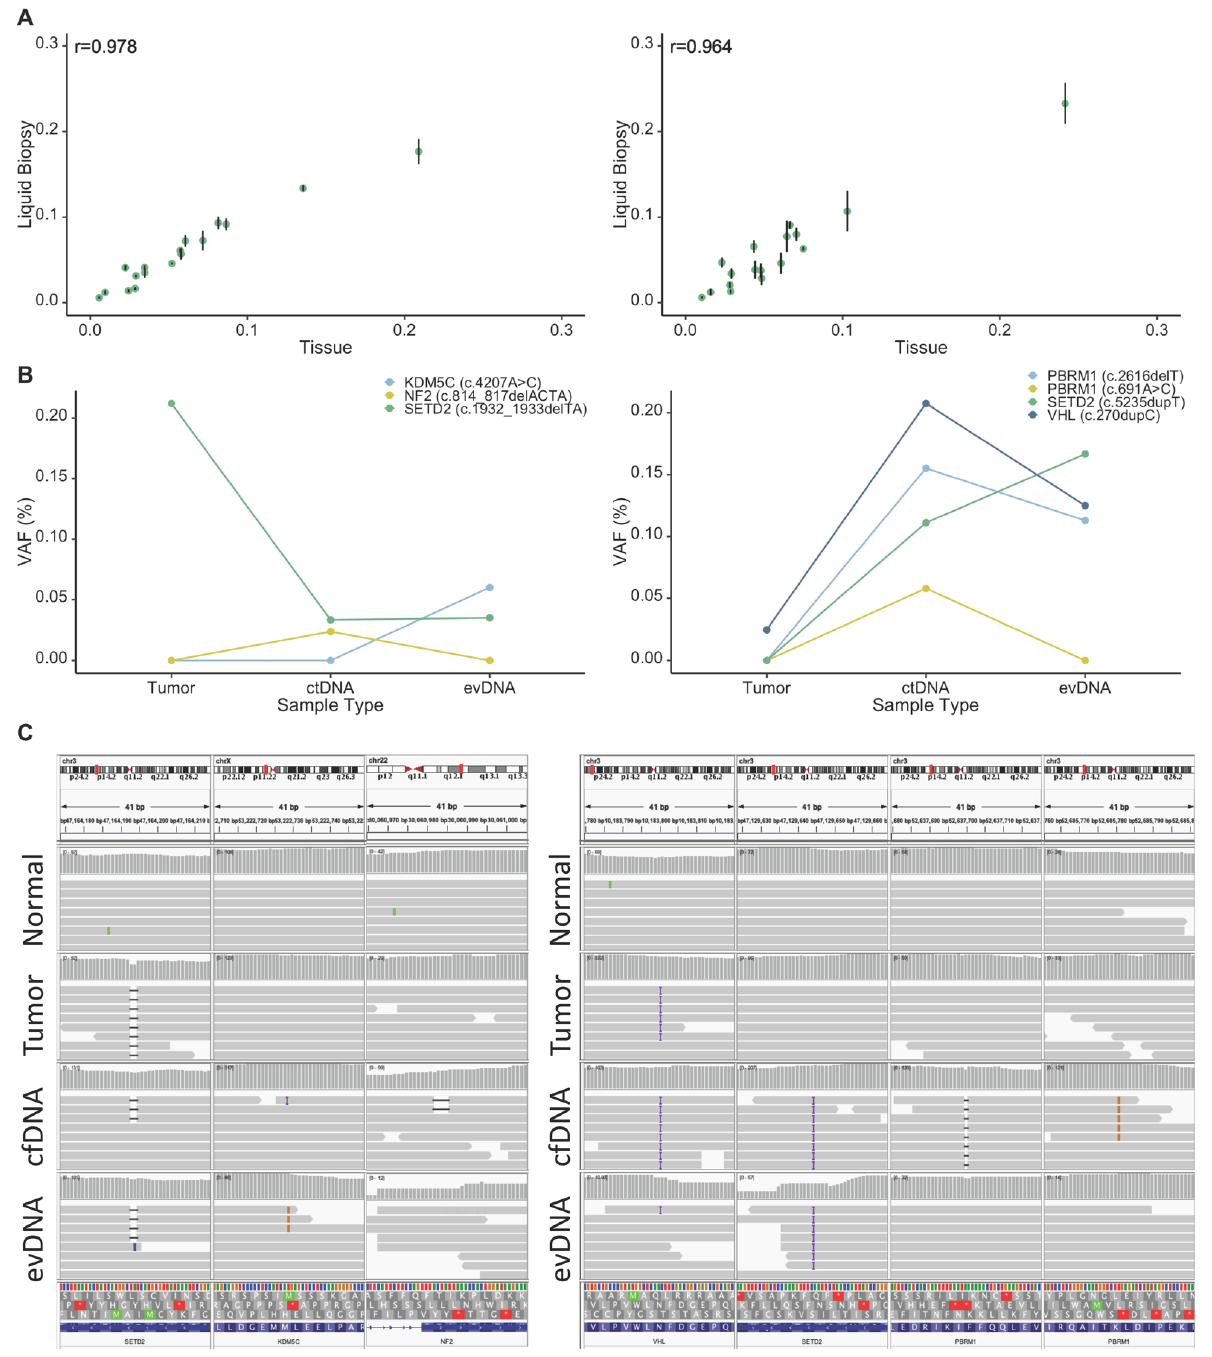
Figure 4. Evaluating the feasibility of detecting tumor somatic mutations in liquid biopsy in RCC. ( A ) In-patient comparisons between tumor and liquid biopsy-driven DNA samples showed high Pearson’s correlation in capture distribution. Example data is shown for two patients (r = 0.978, p < 0.0001 and r = 0.964, p < 0.0001, for P10 and P11 respectively). Error bars show SD within liquid biopsies. ( B ) Somatic variants identified in both tumor tissue, and in liquid biopsy fractions for patients P10 (left) and P11 (right) at variable allele frequencies. The SETD2 variant in patient P10 was detected at low frequencies in both ctDNA and evDNA, whereas the KDM5C variant was detected only in the evDNA fraction, and the NF2 variant was detected only in the cfDNA fraction. The VHL variant identified in P11 tumor, showed an increased allele frequency in liquid biopsy fractions, whereas mutations in PBRM1 and SETD2 were only detected in liquid biopsy fractions. ( C ) Somatic variants identified in tumor tissue, ctDNA, and evDNA visualized using Integrative Genomics Viewer (IGV) for both patient P10 (left) and P11 (right). These somatic variants were not present in the normal (buffy coat) samples (top panel). SD: standard